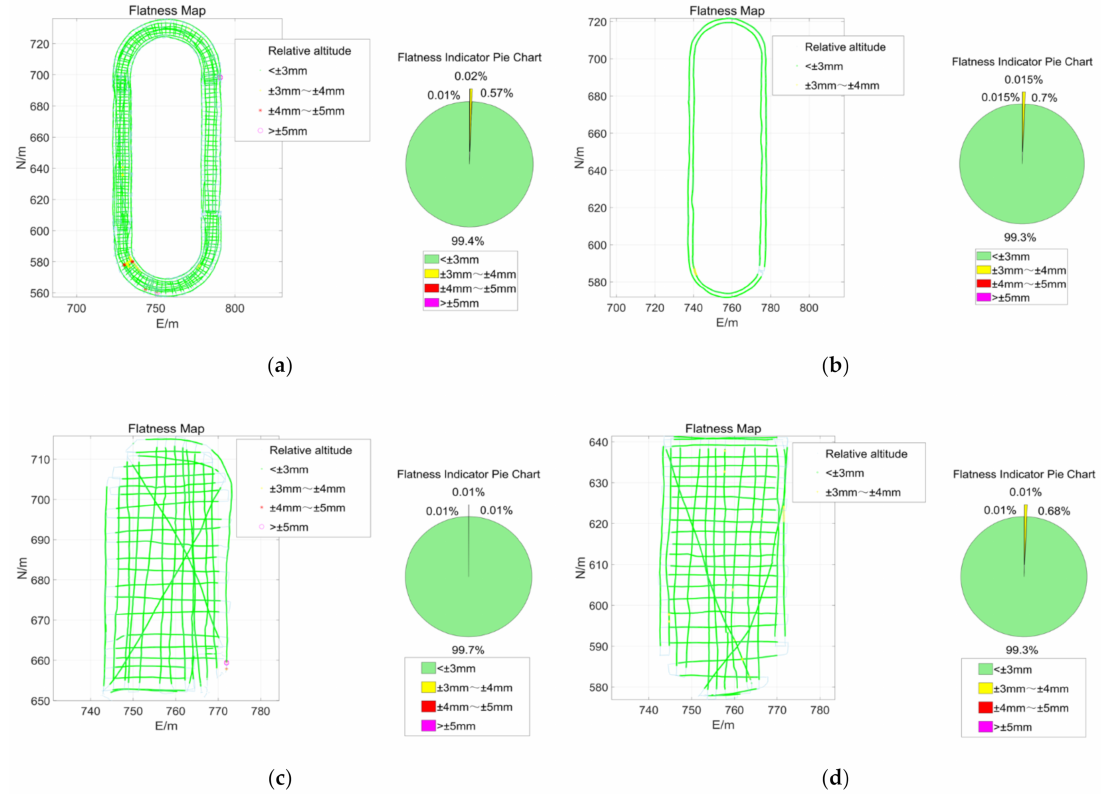
Figure 12. Map and statistics analysis of flatness measurement results of different blocks. ( a ) the racetrack. ( b ) the practice track. ( c ) the north inner rink. ( d ) the south inner